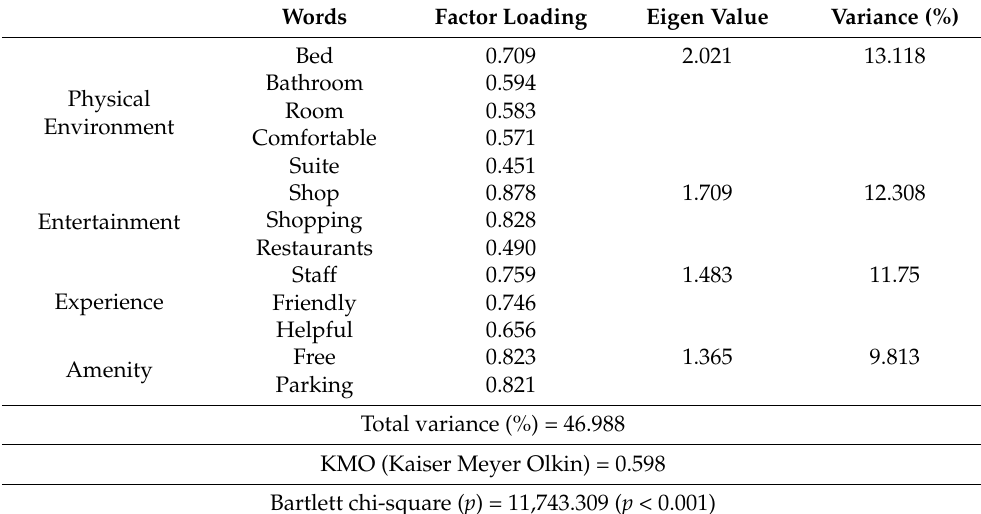
Table 6. Result of the factor analysis (The Venetian in Las Vegas).